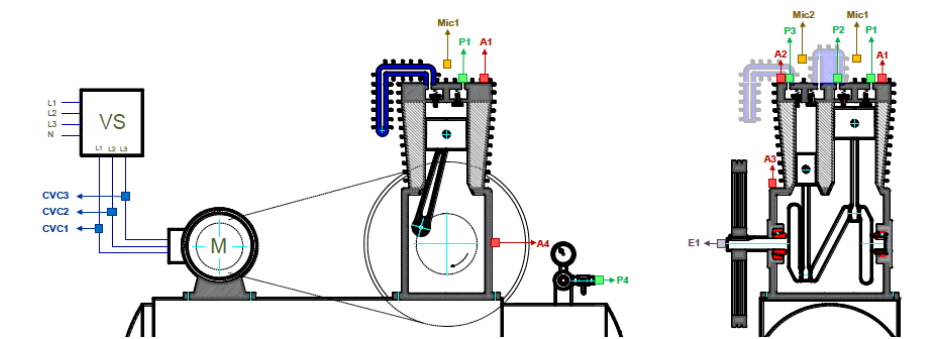
Figure 13. Location of the accelerometers sensors for recording the vibration